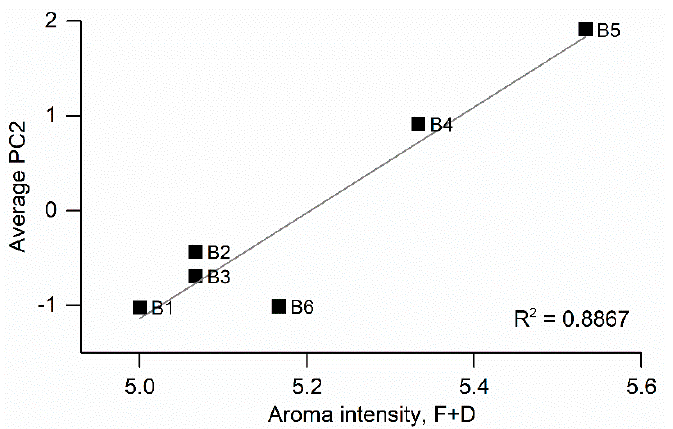
Figure 4. Correlation between average aroma intensity (F + D) obtained from panel test results and average principal component 2 (PC2) for a single measurement session. average principal component 2 (PC2) for a single measurement session.